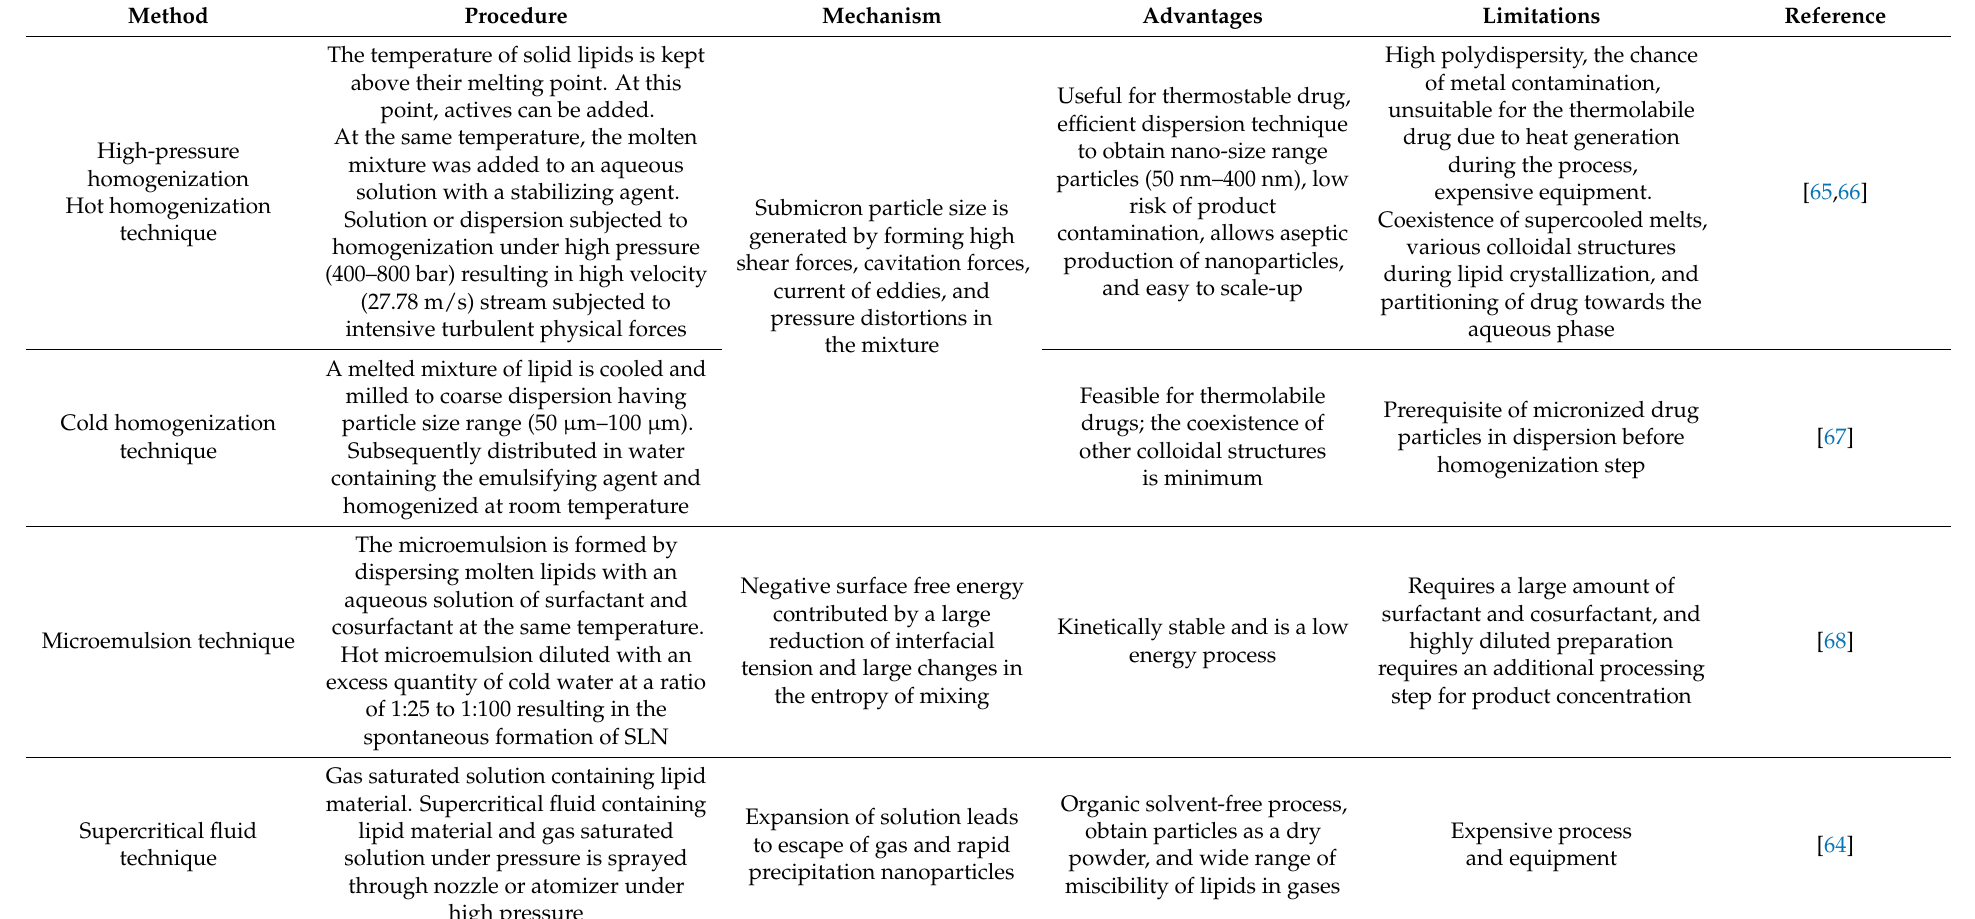
Table 2. List depicting various solid lipid nanoparticles preparation methods, procedures, advantages, and